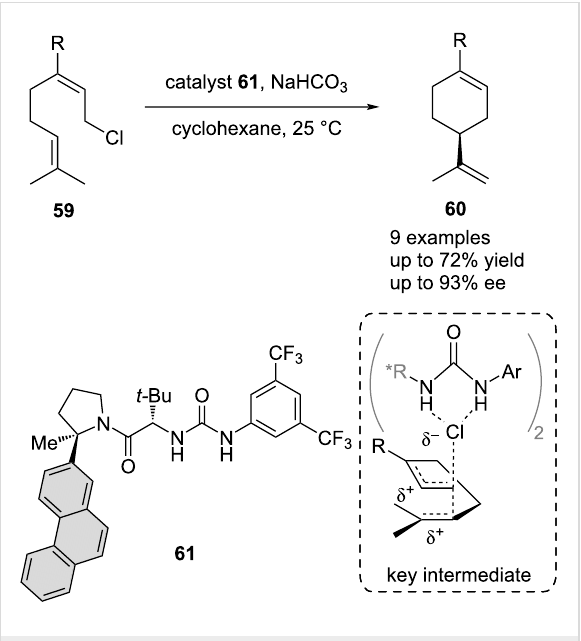
Scheme 13: Enantioselective tail-to-head cyclization of neryl chloride derivatives.